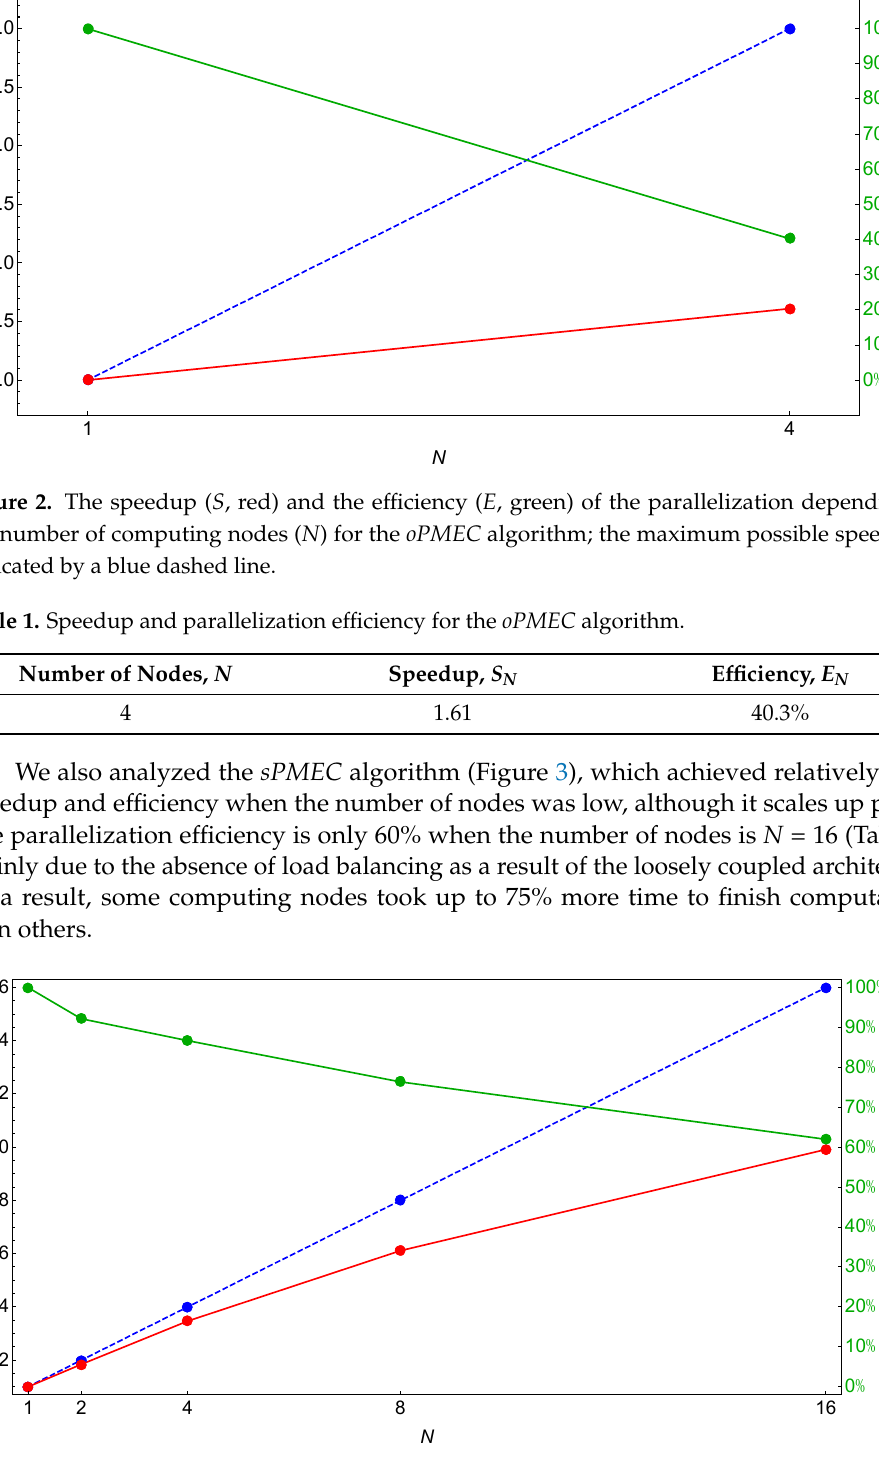
Figure 3. The speedup ( S , red) and the efficiency ( E , green) of the parallelization depending on the number of computing nodes ( N ) for the sPMEC algorithm; the maximum possible speedup is indicated by a blue dashed line.